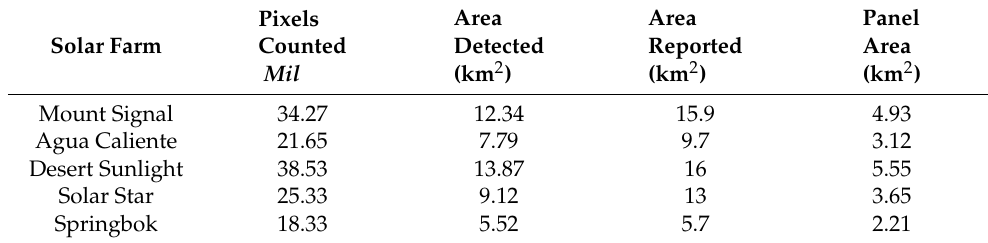
Table 3. Area Detection—the first step in capacity evaluation. Note that detected area is purely panel outlines while reported area includes peripheral area.